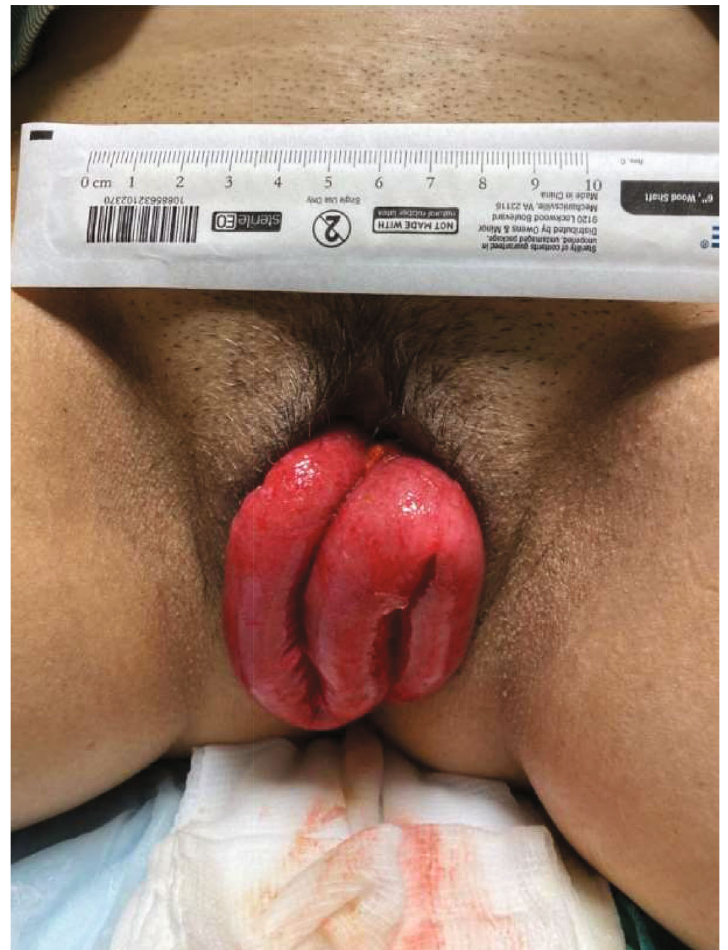
Figure 1: Loop of the small bowel protruding from the vagina that is hyperemic with no evidence of gross ischemia (photo with signed consent from